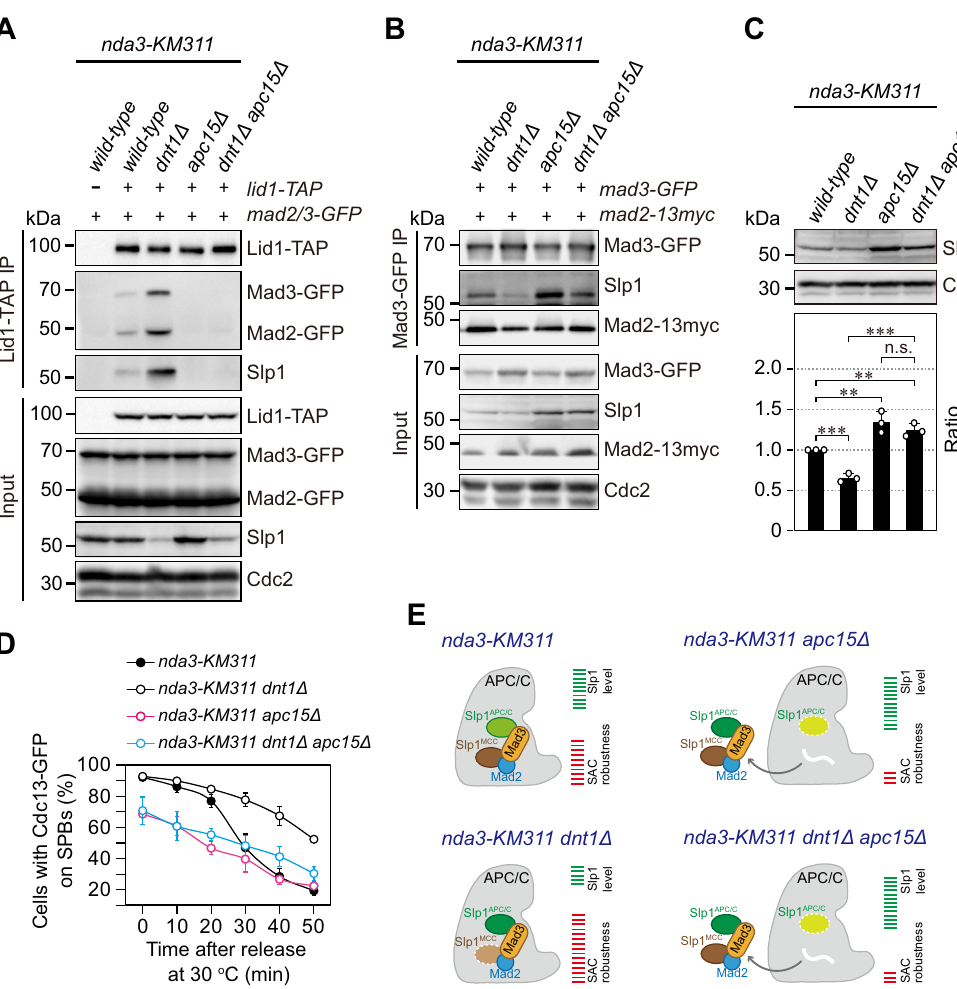
Mad3-GFP immunocomplexes in dnt1 Δ cells (Fig 4A and 4B). Interestingly, apc15 Δ restored Slp1 Cdc20 levels bound to MCC in dnt1 Δ cells (Fig 4B). These observations seem to support the idea that the efficiency of Slp1 Cdc20 being co-immunoprecipitated by APC/C subunit or MCC component differs significantly. Also, these data suggested that the increased APC/C-